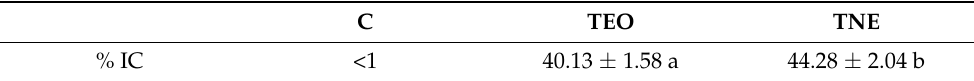
Table 3. The antiradical DPPH inhibition capacity (IC, expressed as %) measurement of bulk (TEO) nanoencapsulated (TNE) T. capitatus EO (300 µ g/mL) and control (C) formed of nanoemulsion components without EO. Values followed by different letters mean statistically significant differences ( p < 0.01). C TEO TNE % IC <1 40.13 ± 1.58 a 44.28 ± 2.04